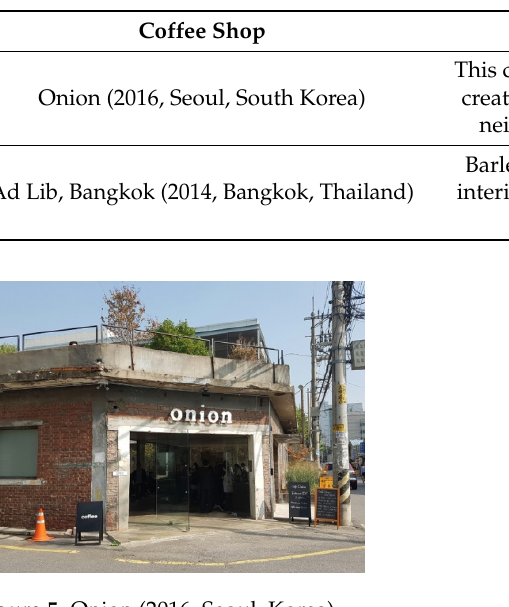
Figure 5. Onion (2016, Seoul, Korea).